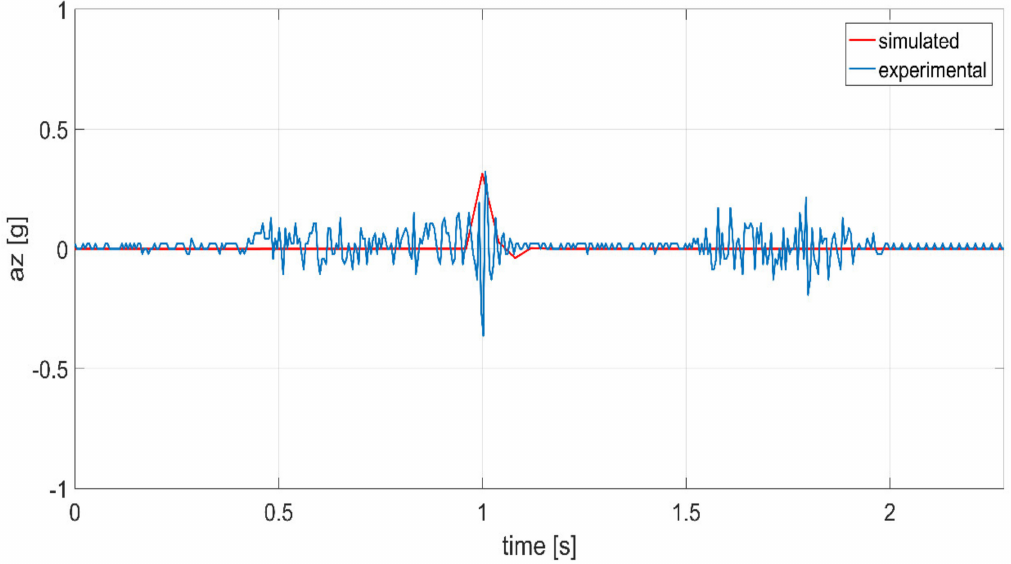
Figure 19. Comparison of the simulated and experimentally measured acceleration along Z-axis versus time during a grasping